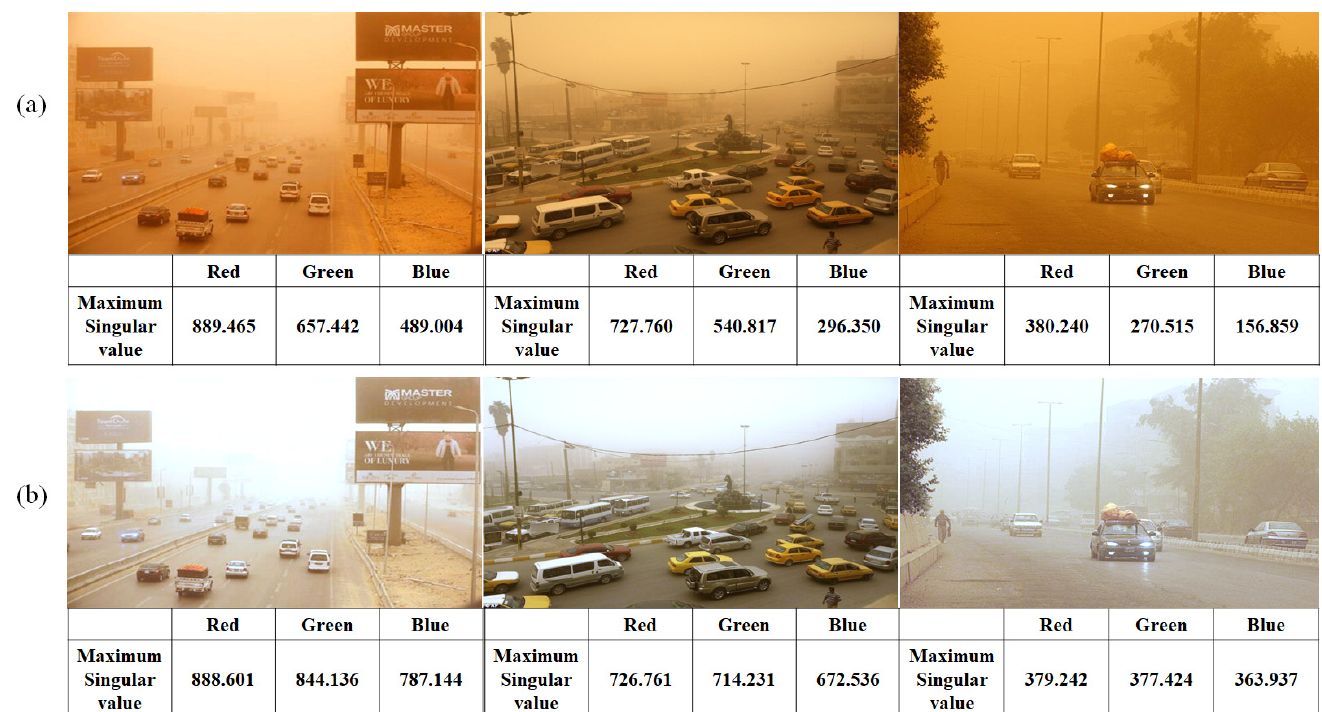
Figure 2. The degraded duststorm images ( a ) and their color corrected images ( b ). (The tables below the images indicate each channel’s maximum singular value).